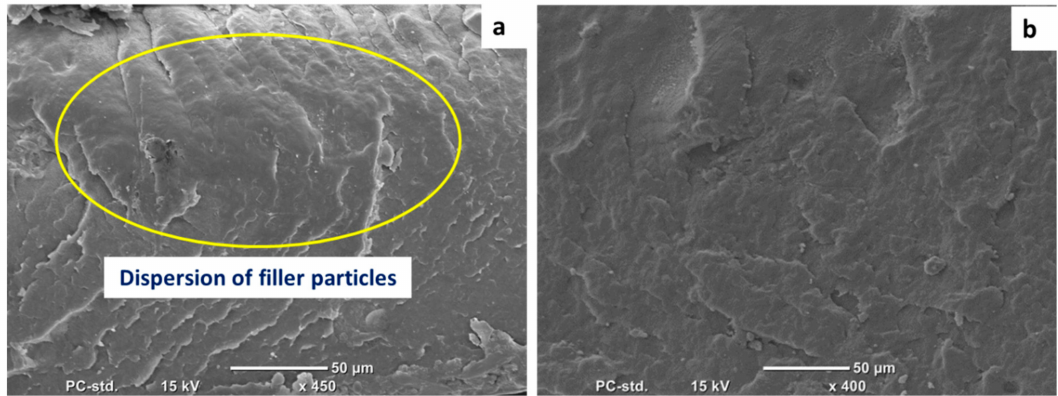
Figure 2. SEM micrographs of the fillers on a conductive adhesive tape: ( a ) P3; ( b ) MG5.